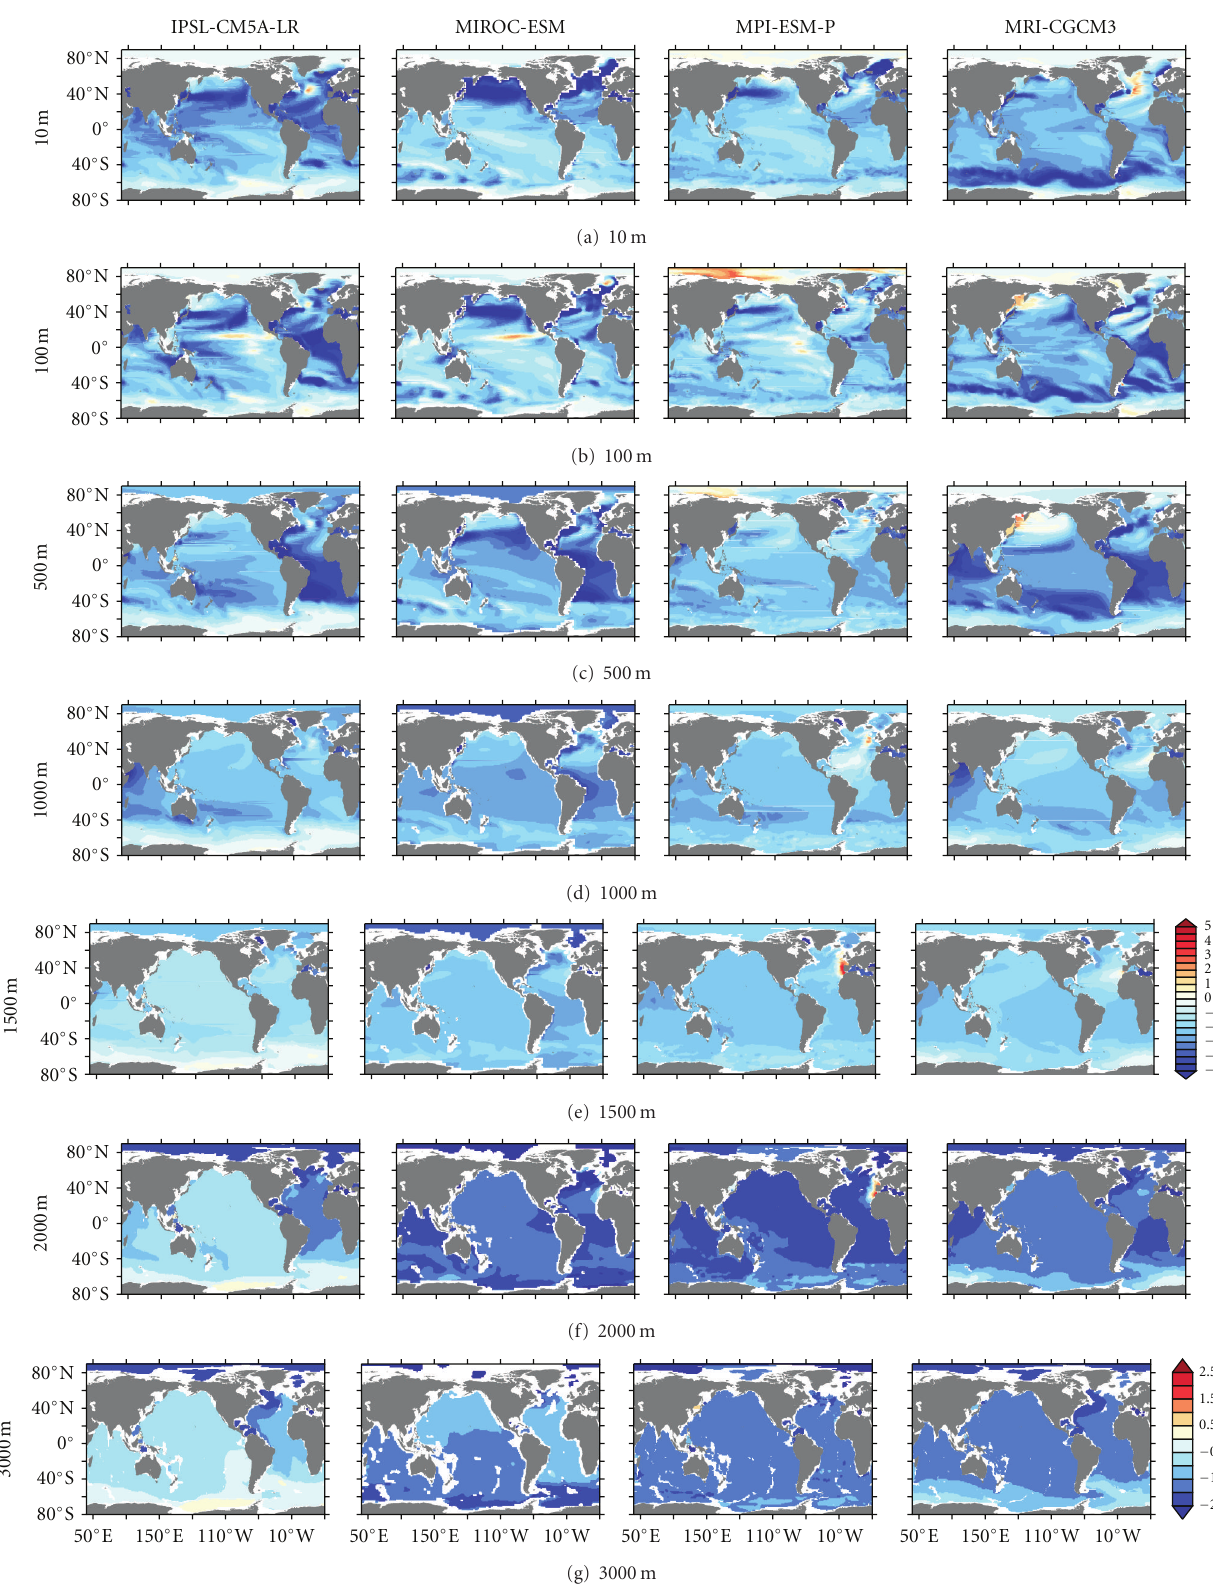
Figure 1: Geographical distribution of potential temperature anomaly in ◦ C at di ff erent water depths. The abscissa is longitude in degrees and the ordinate is latitude in degrees. See text for detailed